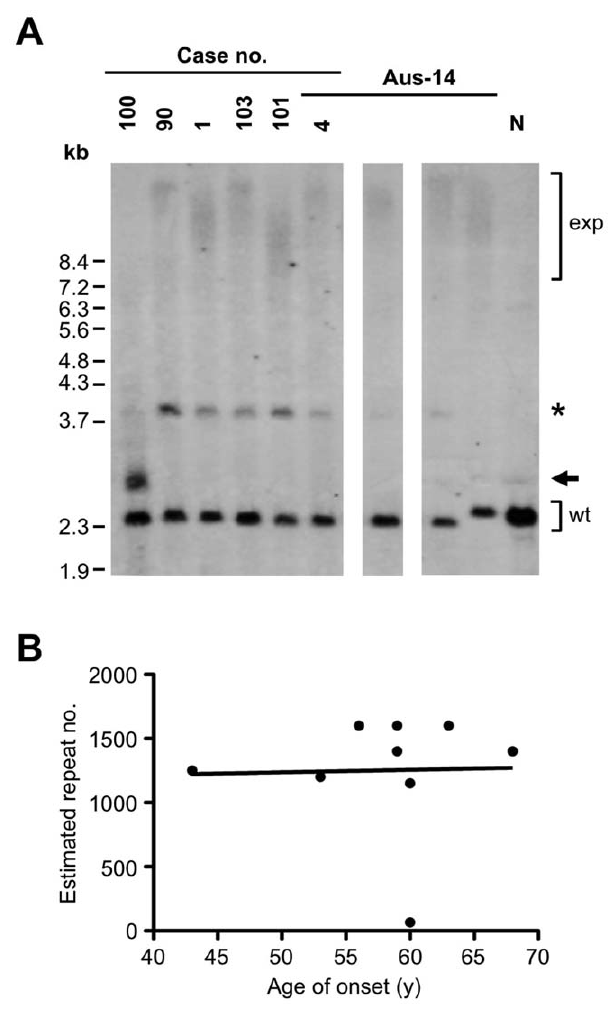
Figure 1. Analysis of C9ORF72 expansion allele size. A, Southern blot analysis of five unrelated probands and four Aus-14 family members with the C9ORF72 repeat expansion, plus an expansion- negative control (N). Wild-type (wt) and expansion (exp) alleles are indicated; the smaller expansion allele in case 100 is arrowed. A band running at , 3.8 kb was also observed (asterisk); this probably arises from unspecific probe binding. B, Scatter plot of age of onset of disease versus estimated mean number of C9ORF72 hexanucleotide repeats in expansion allele carriers.